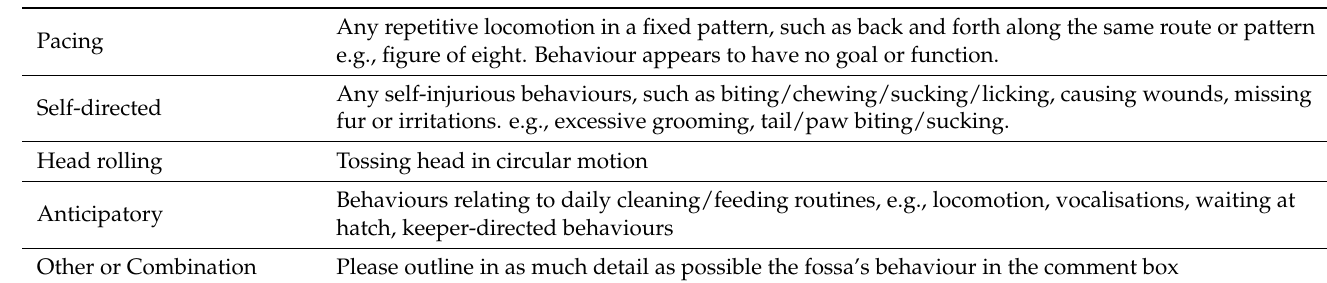
Table 2. Unnatural behaviour categories and definitions from the global housing and husbandry survey (2017). Any repetitive locomotion in a fixed pattern, such as back and forth along the same route or pattern Pacing e.g., figure of eight. Behaviour appears to have no goal or function. Any self-injurious behaviours, such as biting/chewing/sucking/licking, causing wounds, missing Self-directed fur or irritations. e.g., excessive grooming, tail/paw